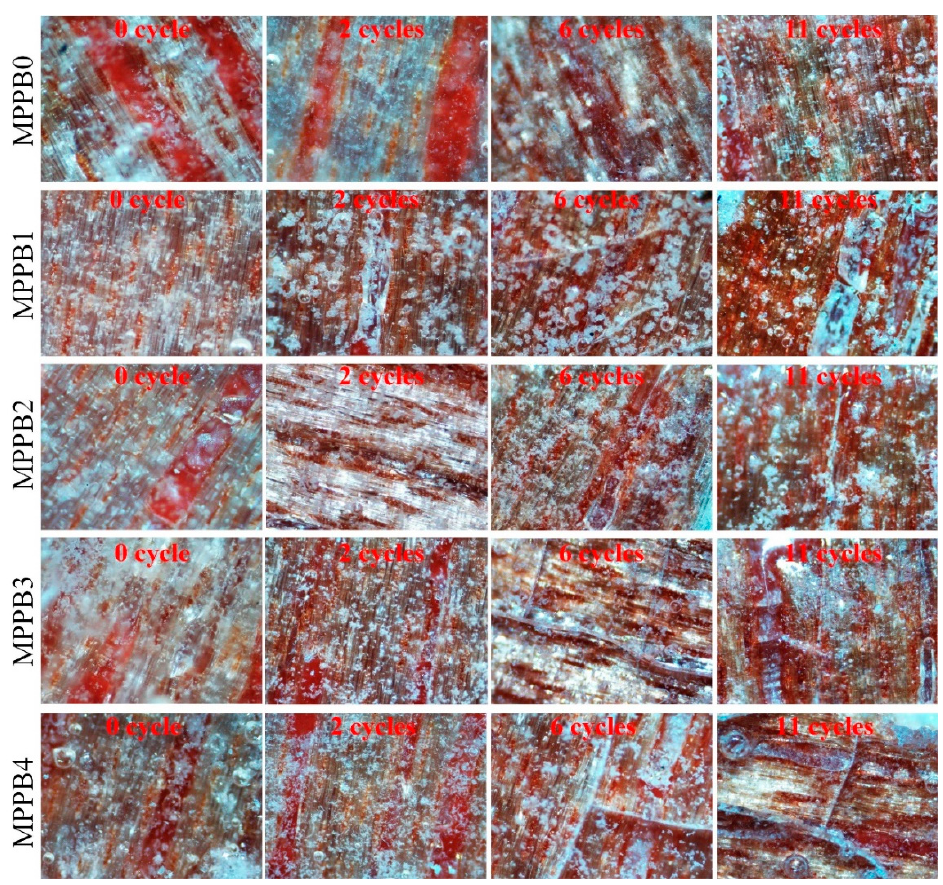
Figure 10. Optical micrographs of the transparent coatings after accelerated ageing test.